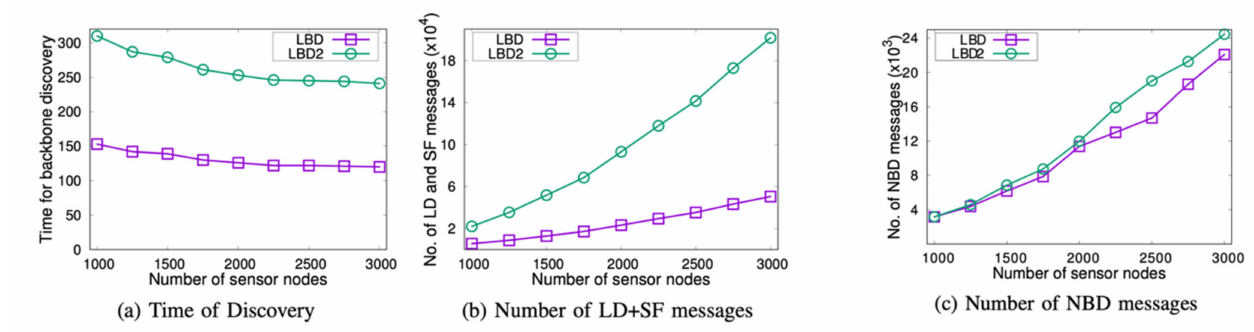
Figure 6. Performance results of the LBD and LBD2 algorithms as the number of sensor nodes increases, with the communication range fixed at 100 [39]. ( a ) Time of Discovery ( b ) Number of LD + SF messages ( c ) Number of NBD messages.